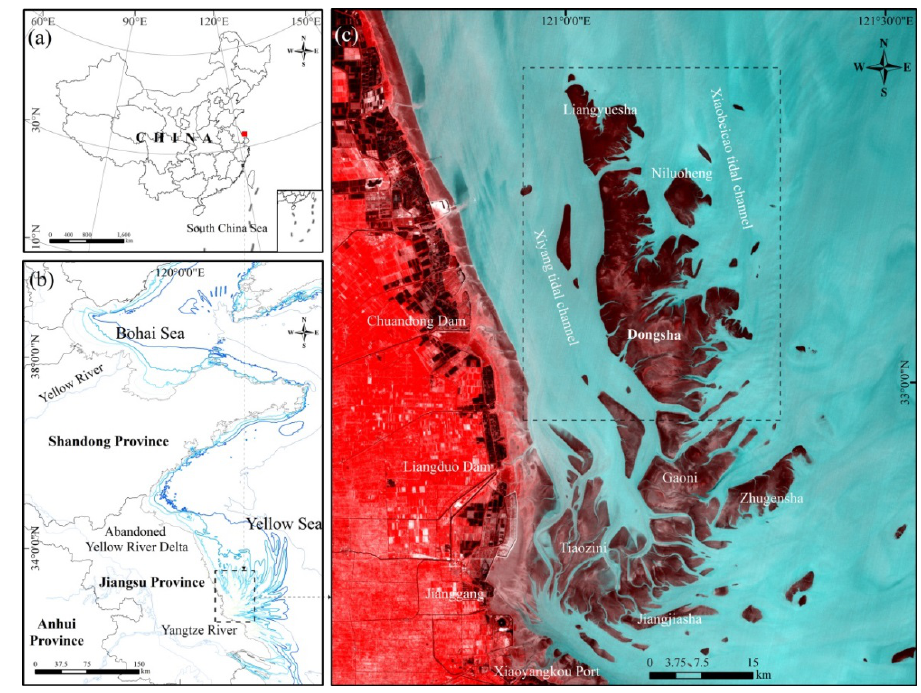
Figure 1. Location maps of the Dongsha Sandbank ( a ) in China and ( b ) in the South Yellow Sea Radial Sand Ridges (SYSRSR); ( c ) HJ-1B Charge Coupled Device (CCD) false-color image of the study area using the near-infrared (band 4), red (band 3) and green spectral bands (band 2) mapped to RGB, acquired at Greenwich Mean Time (GMT) 02:36, 24 January